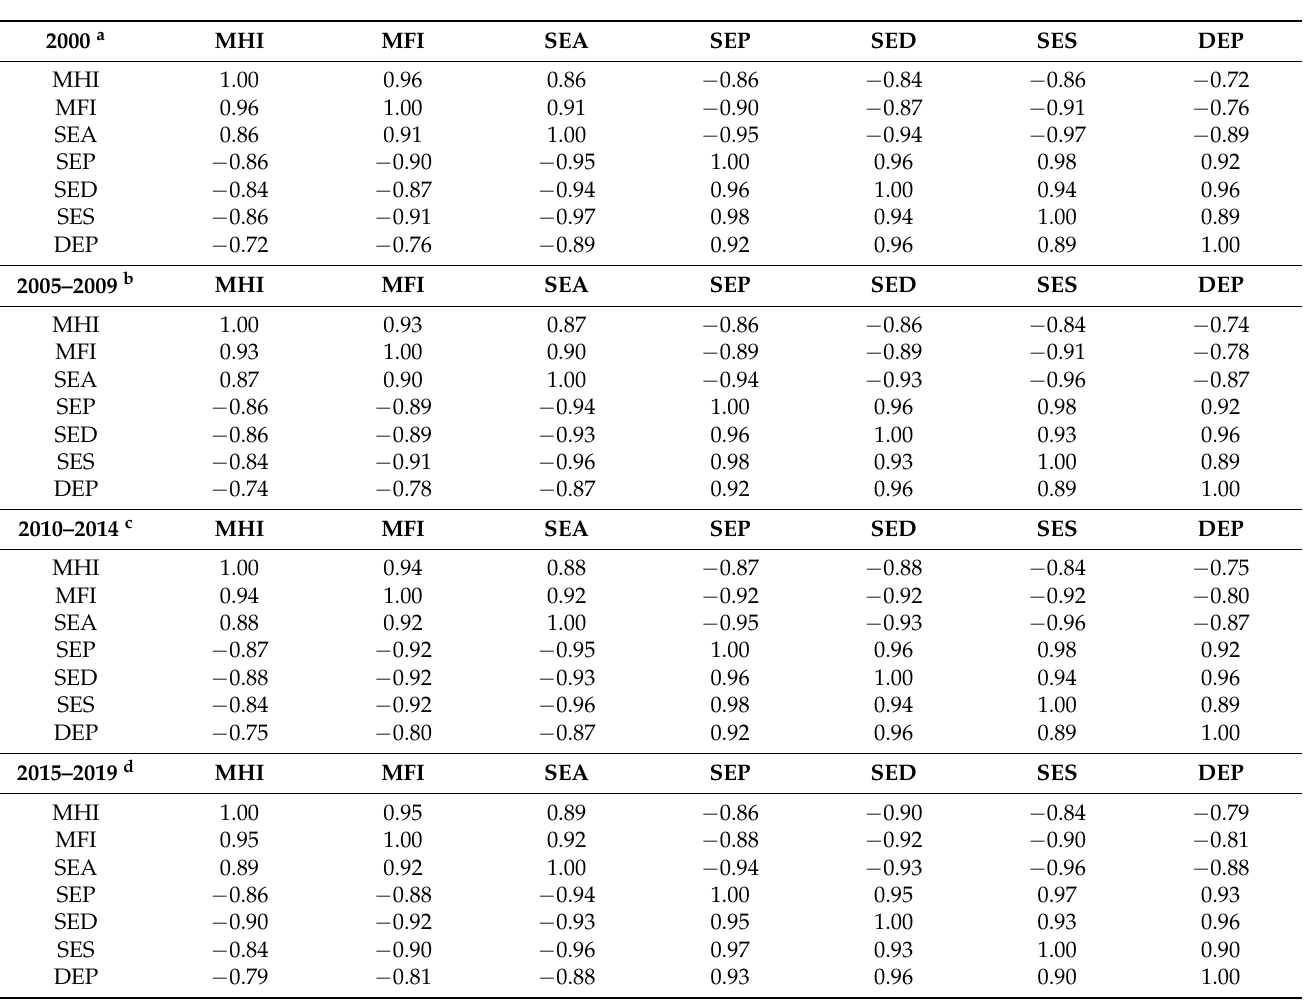
Table 7. Relationships between simple and composite measures of neighborhood socioeconomic status in the San Diego–Chula Vista–Carlsbad Metropolitan Statistical